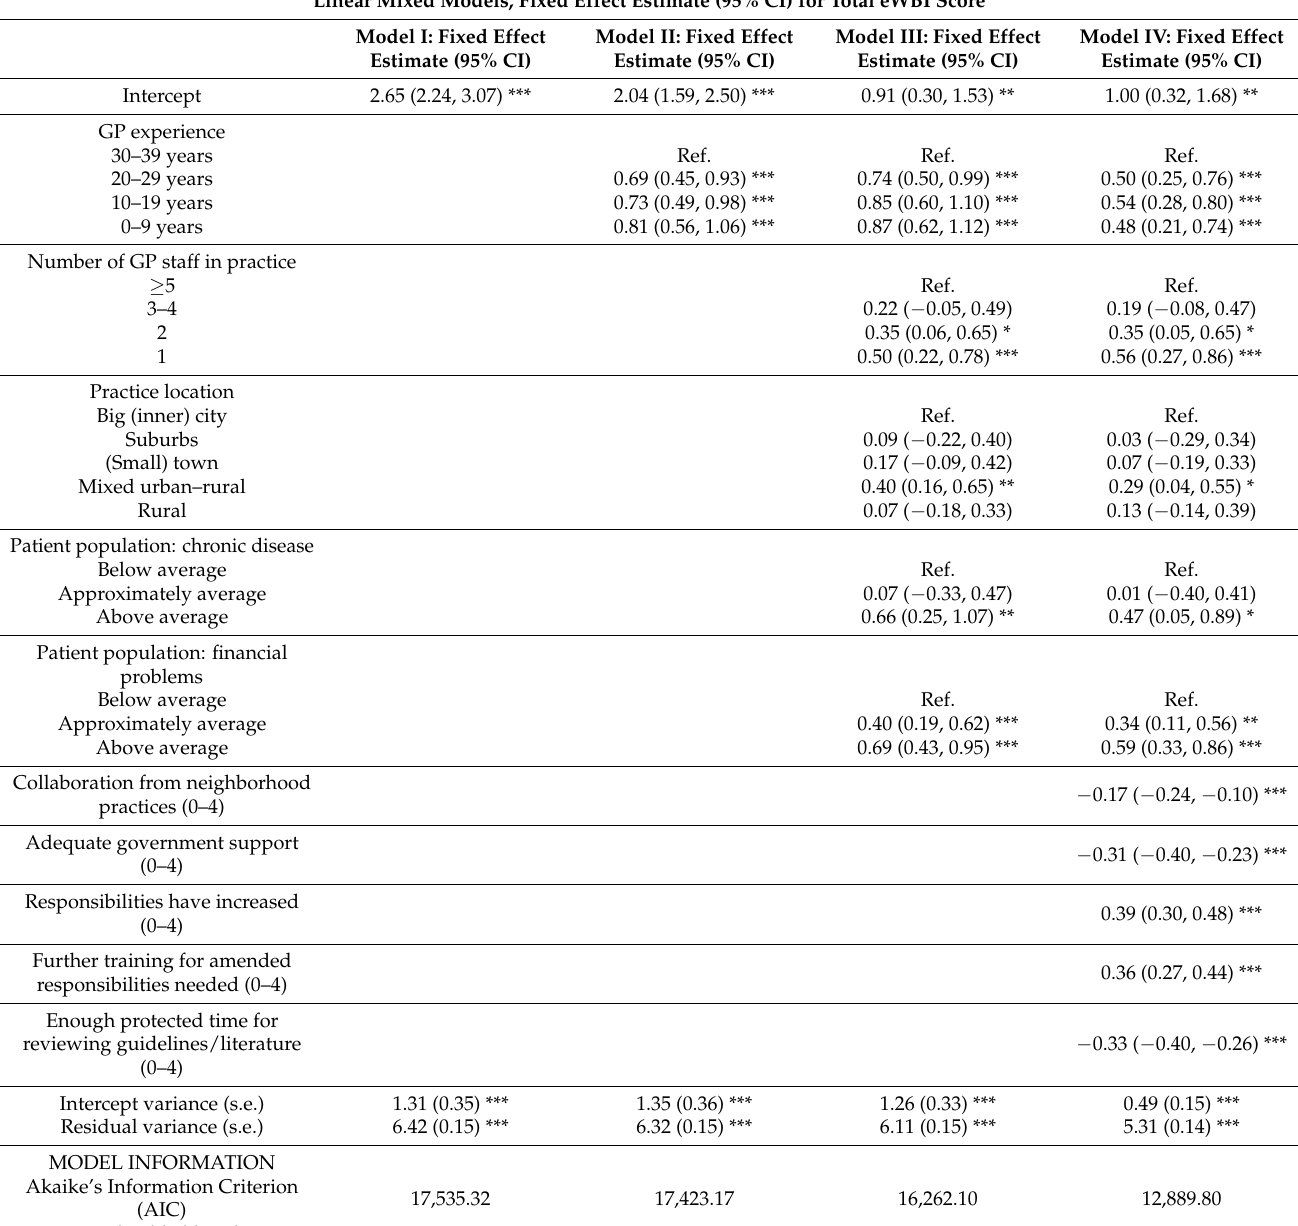
Table 4. Results of linear mixed model analysis of potential predictors for GPs’ distress(total eWBI score) during the COVID-19